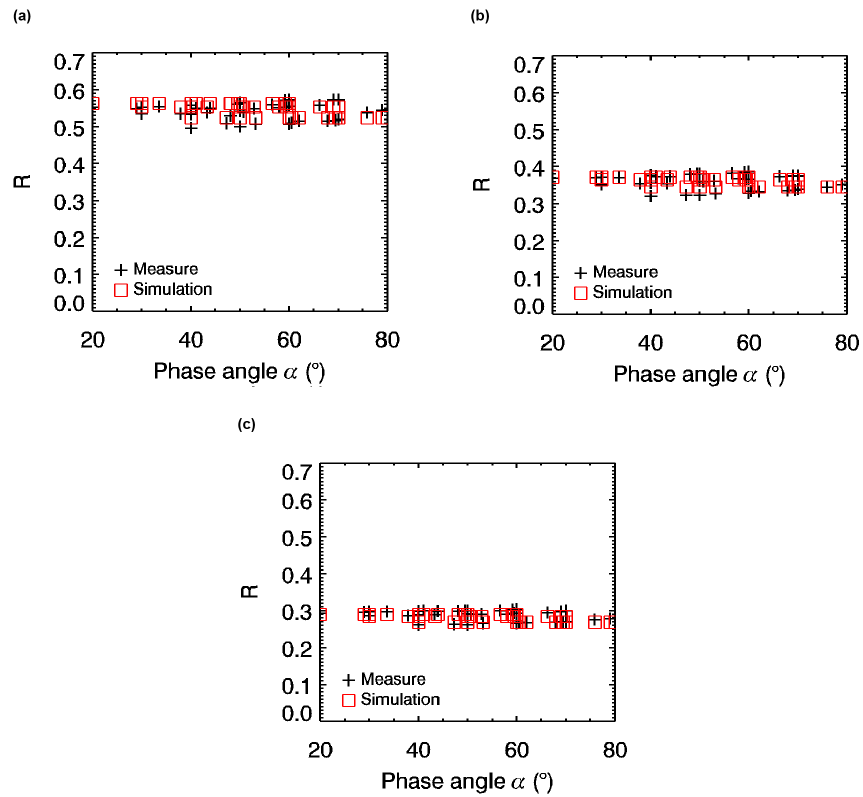
Figure 13. Measured and simulated reflectance factor at λ = 1µm ( R ) for (a) sample 1, (b) sample 2 and (c) sample 3.